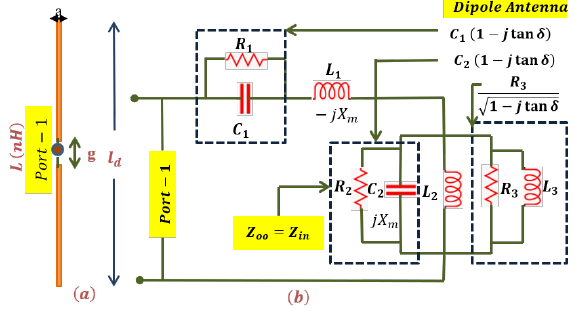
Fig. 6. The proposed lossless dipole antenna ( a ) topology, ( b ) equivalent circuit